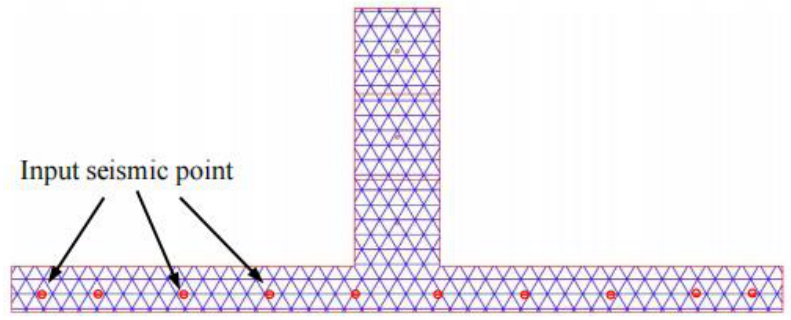
Figure 16. Numerical model of the assembled block system by the NMM. Figure 17. Input horizontal seismic acceleration.